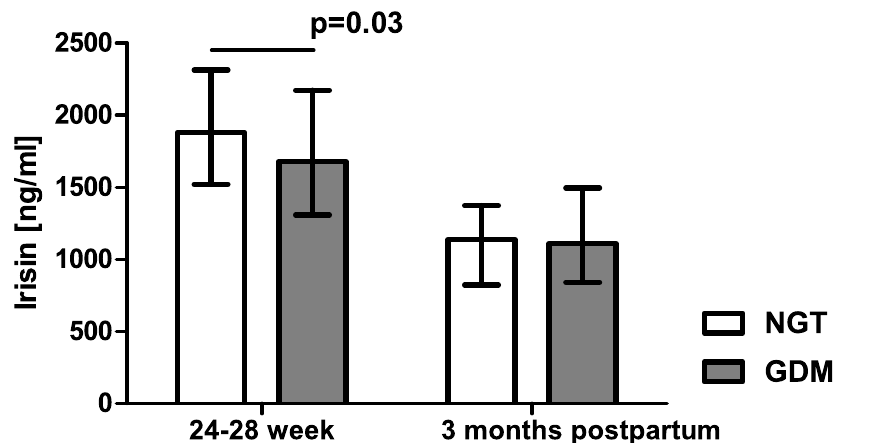
Fig 2. Serum irisin concentration in patients with normal glucose tolerance (NGT) and gestational diabetes (GDM) from Group 1; data were analyzed by Mann-Whitney U test and shown as medians with interquartile